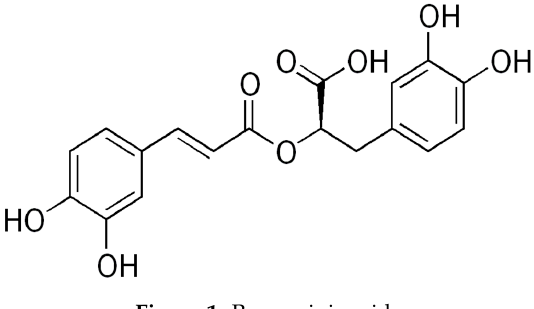
Figure 1. Rosmarinic acid.